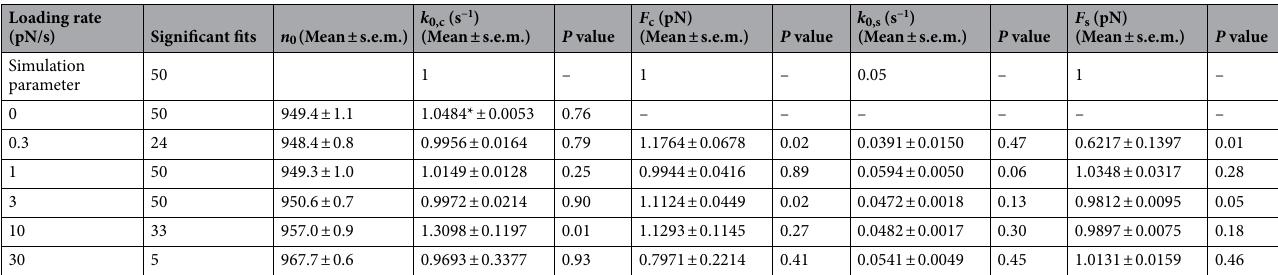
Table 4. Mean fit parameters from simulated catch-slip bond dissociation data sets where short events have been removed. Reported values represent the mean ± s.e.m. of the fit parameters for the same 50 sets of simulated slip bond dissociation data for which the fits were significant, as in Table 2, but where short events corresponding to those that are indistinguishable from experimental noise have been removed. The number of significant fits is indicated. In all cases, P values are calculated for two-tailed t-tests. *